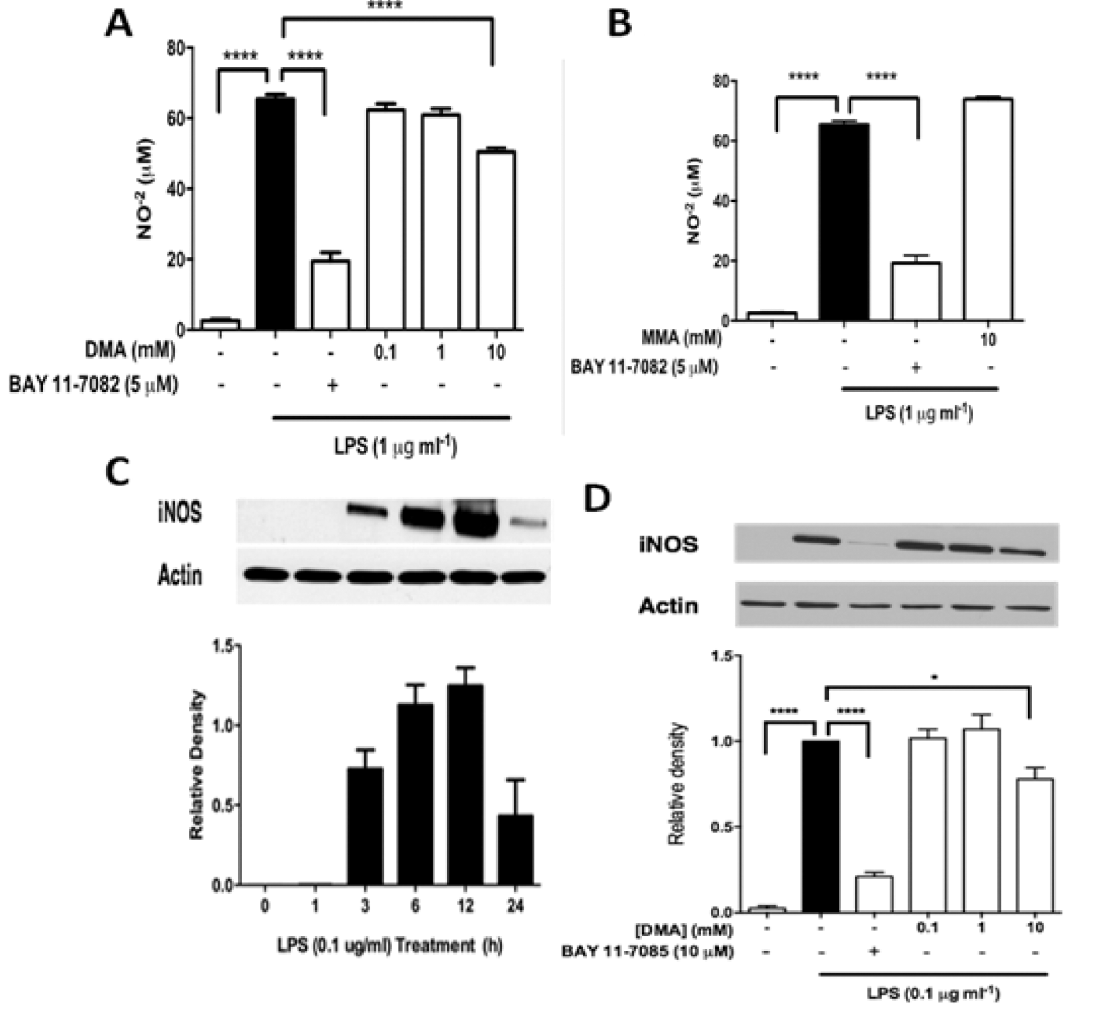
Figure 1. DMA inhibits NO − 2 secretion and iNOS expression. (A) NO − 2 secretion was determined by Griess assay in LPS-stimulated RAW 264.7 cells after incubation with DMA and BAY 11-7082. (B) NO − 2 secretion in LPS-stimulated RAW 264.7 cells after incubation with MMA. (C) Time profile of iNOS expression in LPS-stimulated RAW 264.7 cells. Data shown are means ± SEM of at least three independent ex- periments done in duplicate. * P ≤ 0.05; **** P ≤ 0.0001. (D) Immunoblot analysis of iNOS expression after incubation with DMA and BAY